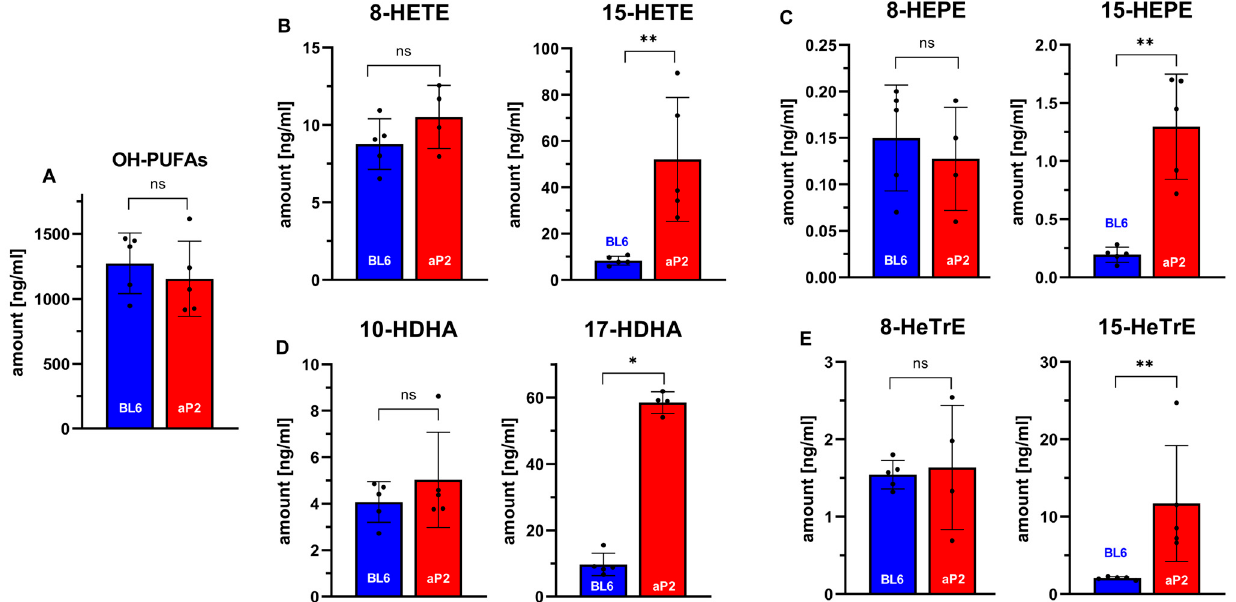
Figure 6. In vivo ALOX15 activity assays quantifying selected oxylipins in the blood plasma of aP2-ALOX15 mice and of wildtype controls (C57BL/6). EDTA blood was prepared from sacrificed mice (n = 5 of each genotype) by heart puncture and was incubated in vitro for 15 min at 37 °C. Blood cells were pelleted, and the plasma was shock-frozen. After thawing, total lipids were extracted and hydrolyzed, and the oxylipidomes were quantified by LC-MS/MS (see Section 4). Selected metabolites are shown. ( A ) Sum of all oxygenated fatty acids. ( B ) Selected arachidonic acid oxygenation products. ( C ) Selected 5,8,11,14,17-eicosapentaenoic acid oxygenation products. ( D ) Selected 4,7,10,13,16,19-docosahexaenoic acid oxygenation products. ( E ) Selected 8,11,15-eicosatrienoic acid oxygenation products. ns, statistically not significant, * statistically significant with p < 0.05, ** statistically significant with p < 0.01